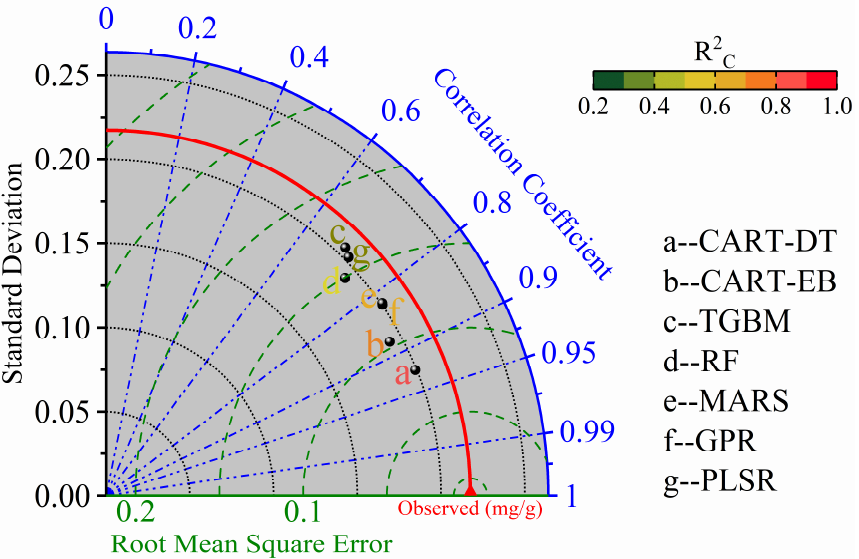
Figure 11. Taylor diagram for the accuracy evaluation of the seven models constructed based on the Car calibration set.